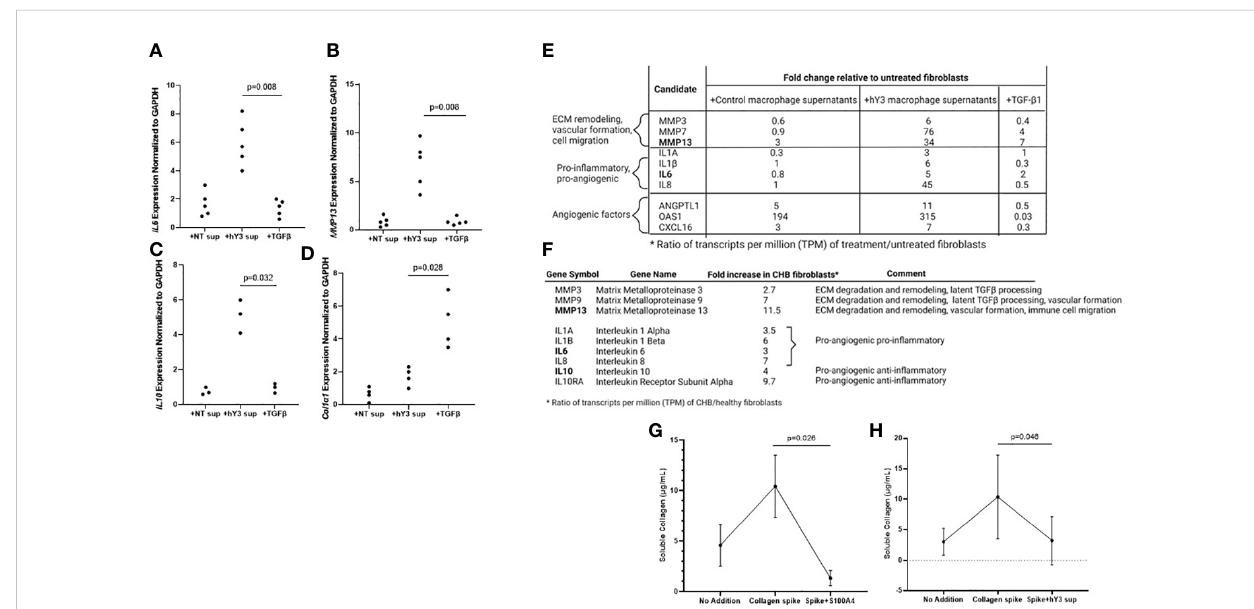
FIGURE 5 Fibroblasts stimulated with hY3 macrophage supernatants, similar to those fl ow-sorted from cardiac-NL hearts, display a matrix-remodeling phenotype based on transcriptomic and cell biological evaluations. Transcripts of IL6 (A) , MMP13 (B) , IL10 (C) , and COL1 a 1 (D) were measured in fi broblasts after varied treatment (24 hours) with macrophage supernatants (NT/DOTAP, 1:5 vol/vol), hY3-treated macrophage supernatants (1:5), activated TGF- b 1 (2.7 ng/mL), or recombinant S100A4 (0.5 µg/mL). The y-axis represents 2^- DD Ct cycle threshold values of the target transcript normalized to GAPDH. p-values are indicated for comparisons of hY3 sup vs NT sup using Mann-Whitney U test. Transcripts IL6 and MMP13 (bold) are among other matrix-remodeling and pro-angiogenic transcripts increased in fi broblasts treated with hY3 macrophage supernatants relative to untreated fi broblasts (E) as assessed via bulk RNA sequencing. Bulk RNA sequencing on fi broblasts fl ow-sorted from CHB hearts similarly showed increased expression of matrix-remodeling MMPs and pro-angiogenic cytokines, including IL6, IL10, and MMP13 (F) . Panels (G, H) show functional evaluations: resting and stimulated fi broblasts were exposed to soluble collagen (12 µg/mL). After 30 hours, the supernatants of the variously treated fi broblasts were assayed for soluble collagen. Both fi broblasts treated with S100A4 (G) and fi broblasts cultured with hY3 macrophage supernatants (H) exhibited collagenase activity in their signi fi cant degradation of the collagen bolus. The bar graphs at Panels (G, H) represent mean ± SEM, over fi ve experiments. The analysis of association of collagen levels and treatment of fi broblasts with exogenous S100A4 or supernatants of hY3-treated macrophages was analyzed by Mann-Whitney U test for n=5